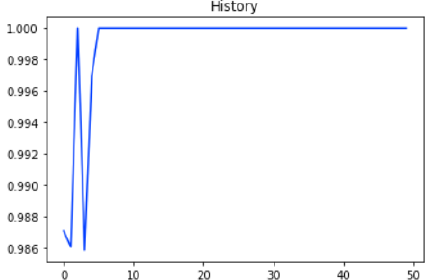
Figure 2. Training history of proposed ensemble model with self-consistency test.